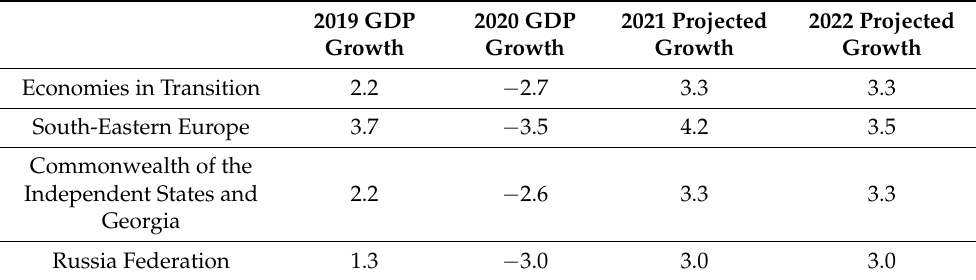
Table 3. Growth of GDP of Economies in Transition.